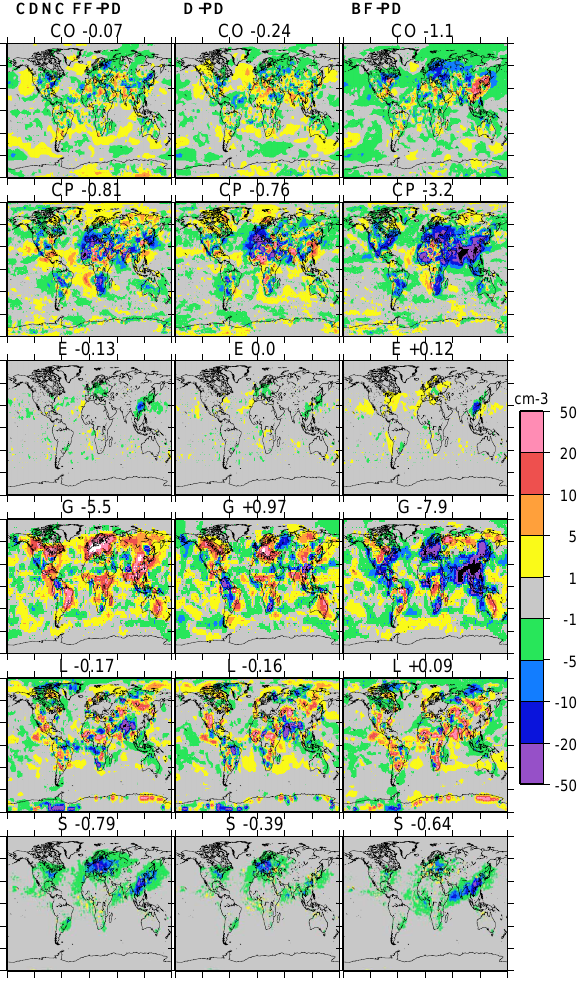
Fig. 3. Difference in annual mean liquid water path (LWP) between the fossil fuel (left), diesel (middle) and biofuel (right) reduction experiments and the full simulation. Each row is one model. The CO model fields are reduced by a factor of 10 to plot on same color